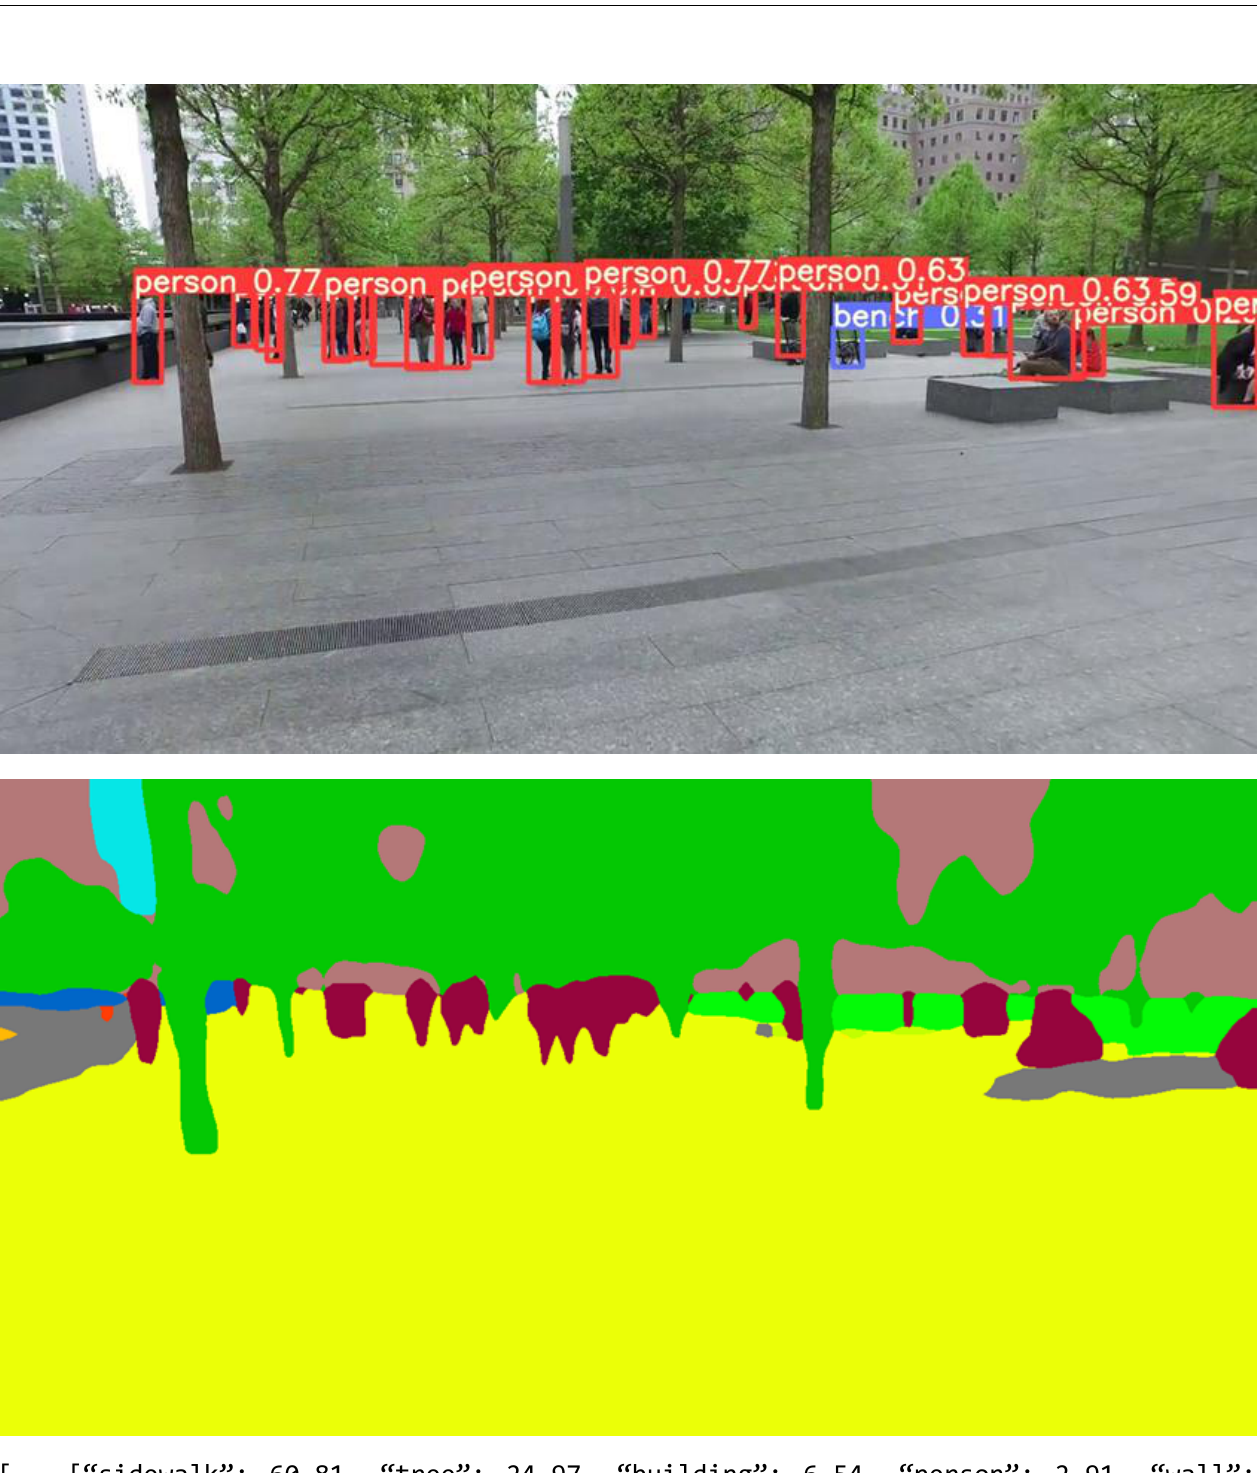
Figure 12. Segmentation of a streetscape scene by machine learning, Top : the original image (with YOLO labels). Bottom : segmentation by ResNet , showing percentages of the scene in each classifica- tion.